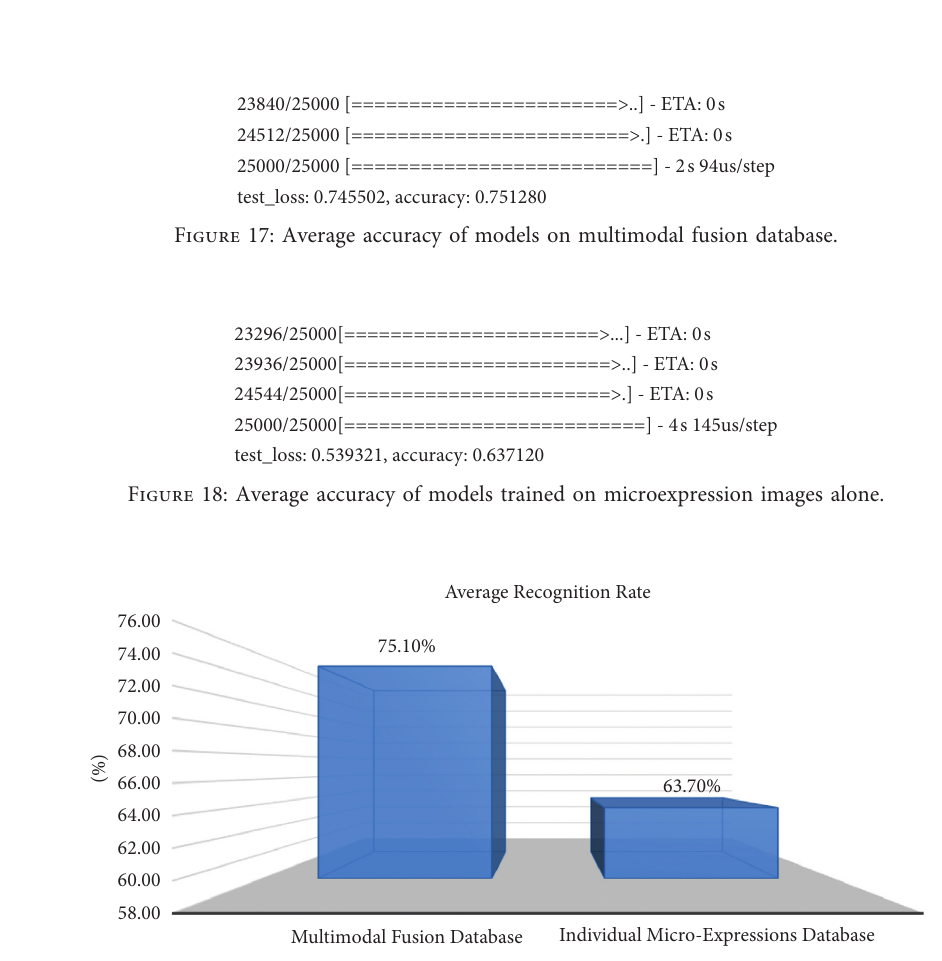
Figure 16: Accuracy curves in CNN +LSTM training (a) and loss function (b).